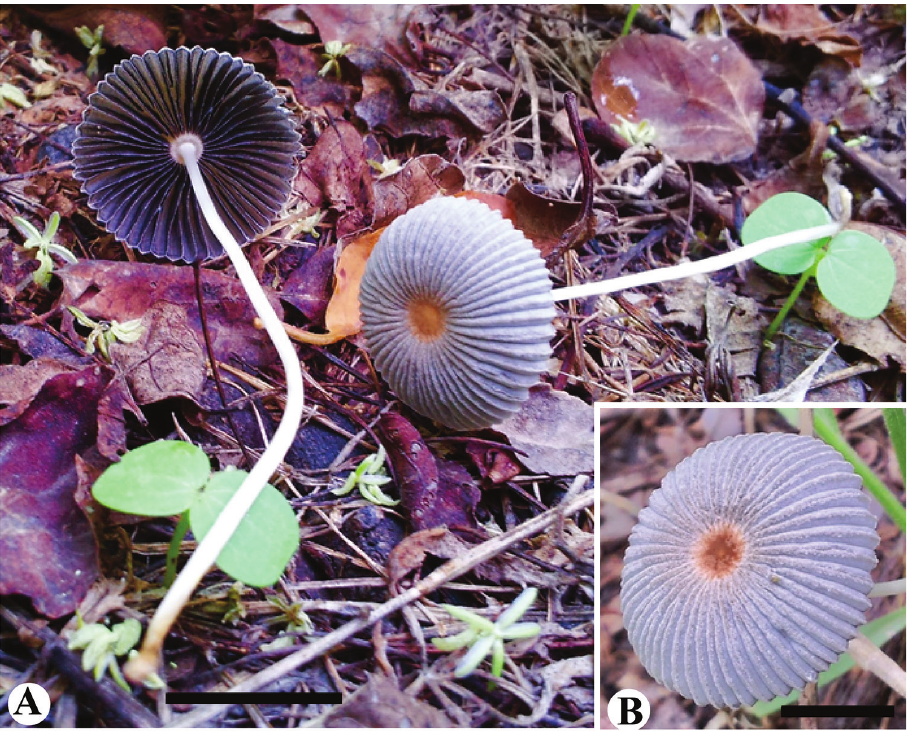
Figure 4. Basidiomata of Parasola glabra sp. nov. A, B Collection SHP-5 (HOLOTYPE LAH-SHP-5). Scale bars: 20